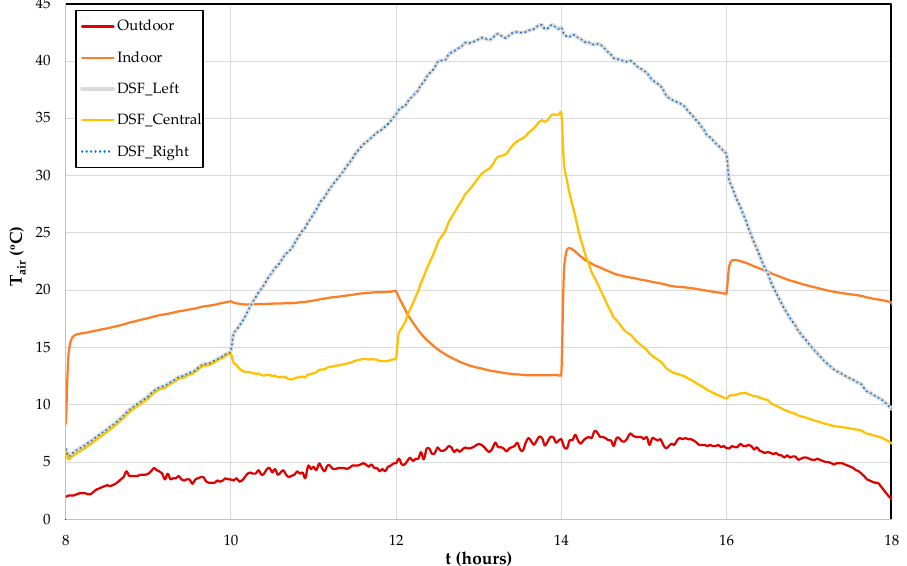
Figure 15. Evaluation of air temperature (T air ) of the outdoor environment, indoor virtual chamber and indoor left, central and right DSF system, when the airflow rate is constant and the number of DSFs to operate is variable, for the Case C.